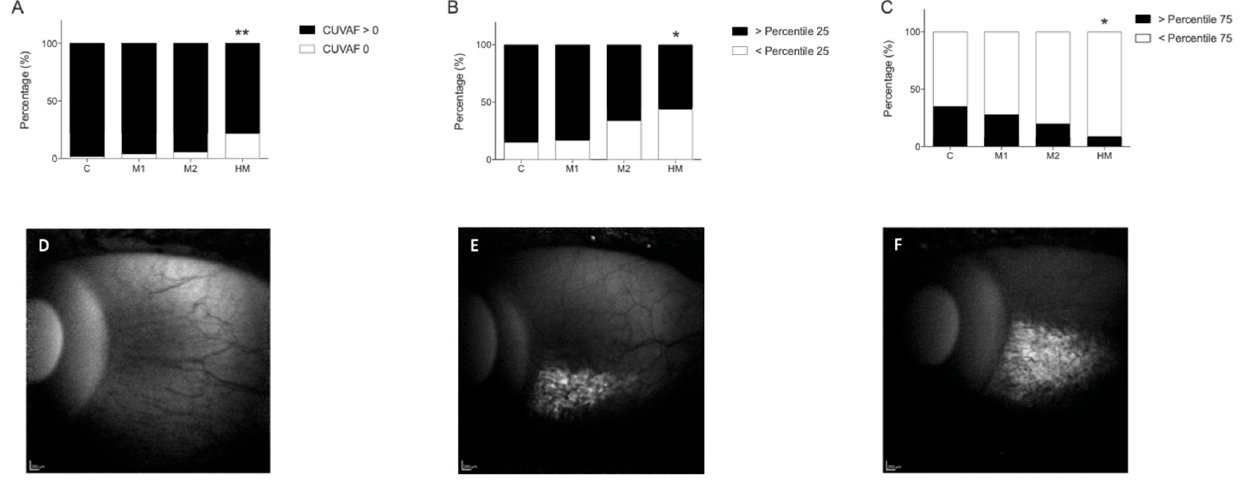
Figure 4. Top row. Frequency of individuals in the study population with CUVAF areas at the 0th, 25th, and 75th percentiles in groups C, M1, M2, and HM. ( A ) Percentage of individuals with CUVAF (mm 2 ) at the 0th percentile. ( B ) Percentage of individuals with CUVAF (mm 2 ) at the 25th percentile. ( C ) Percentage of individuals with CUVAF (mm 2 ) at the 75th percentile. Bottom row. Example of CUVAF areas of individuals belonging to the different percentiles. ( D ) Example of CUVAF area of the 0th percentile. ( E ) Example of CUVAF area of the 25th percentile. ( F ) Example of CUVAF area of the 75th percentile. CUVAF: conjunctival ultraviolet autofluorescence. C: control group (>1.00 D); M: myopic group ( ≤ 1.00 D); M1: − 1.00 to − 3.00 D; M2: − 3.25 to − 5.75 D; HM: High myopia ( ≤− 6.00 D